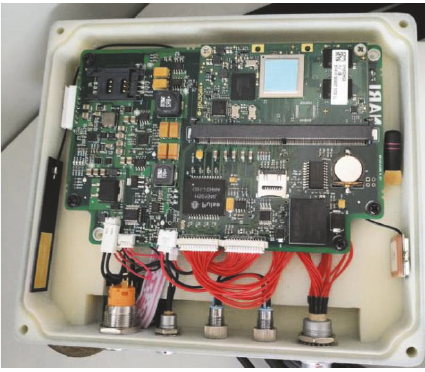
Figure 3: Hardware interface of the SOM